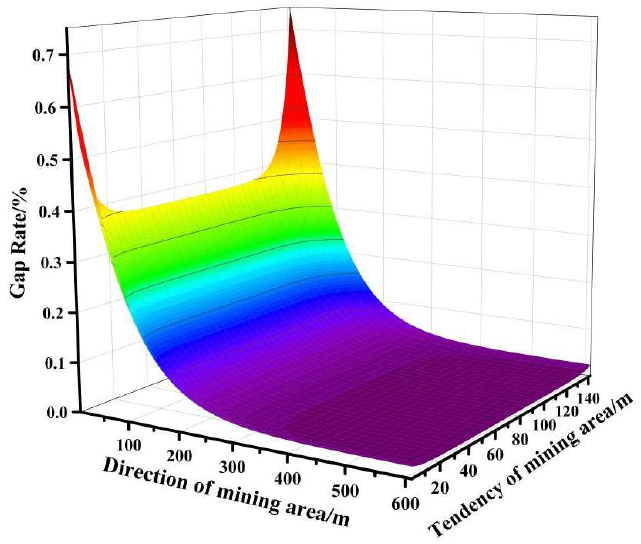
Figure 4. Distribution of void ratio in the extraction area.